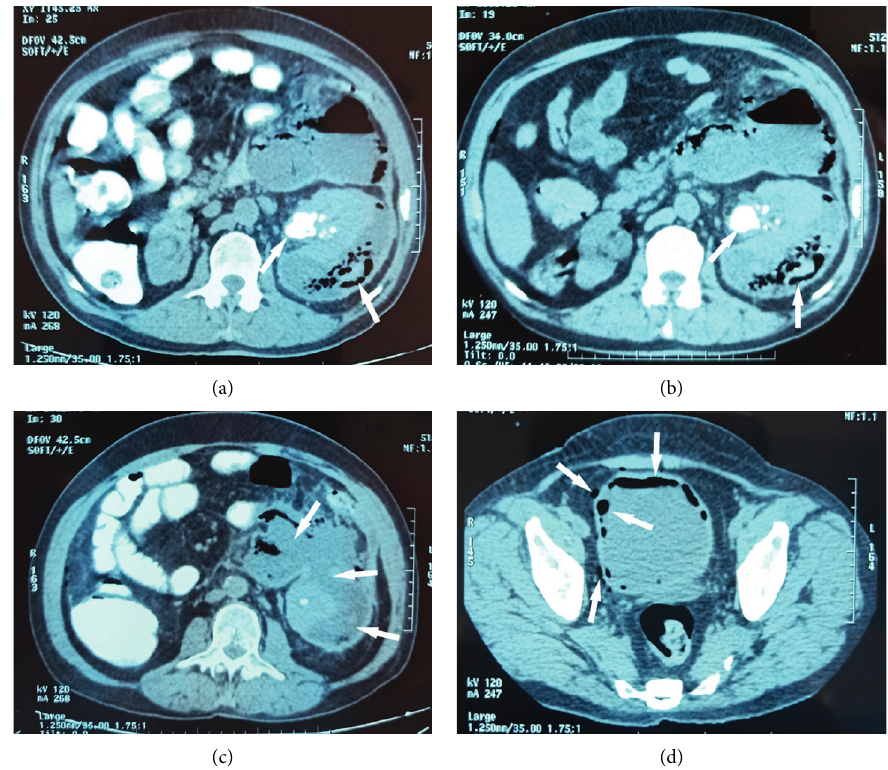
Figure 1: Abdominal CT scan showing (a, b) obstructive emphysematous pyelonephritis on a single functional kidney, (c) renal abscess communicating with intraperitoneal collections measuring approximately 208 × 113mm with no passage of intraperitoneal contrast product at high digestive opacification, and (d) emphysematous